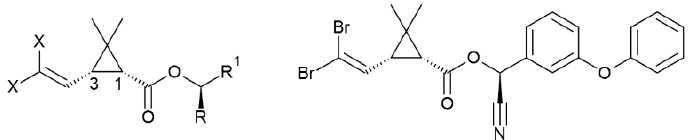
Figure 1. Chemical structure of ( left ) pyrethroids and ( right ) active ( α - S ,1- R - cis ) deltamethrin ( a -DLM).